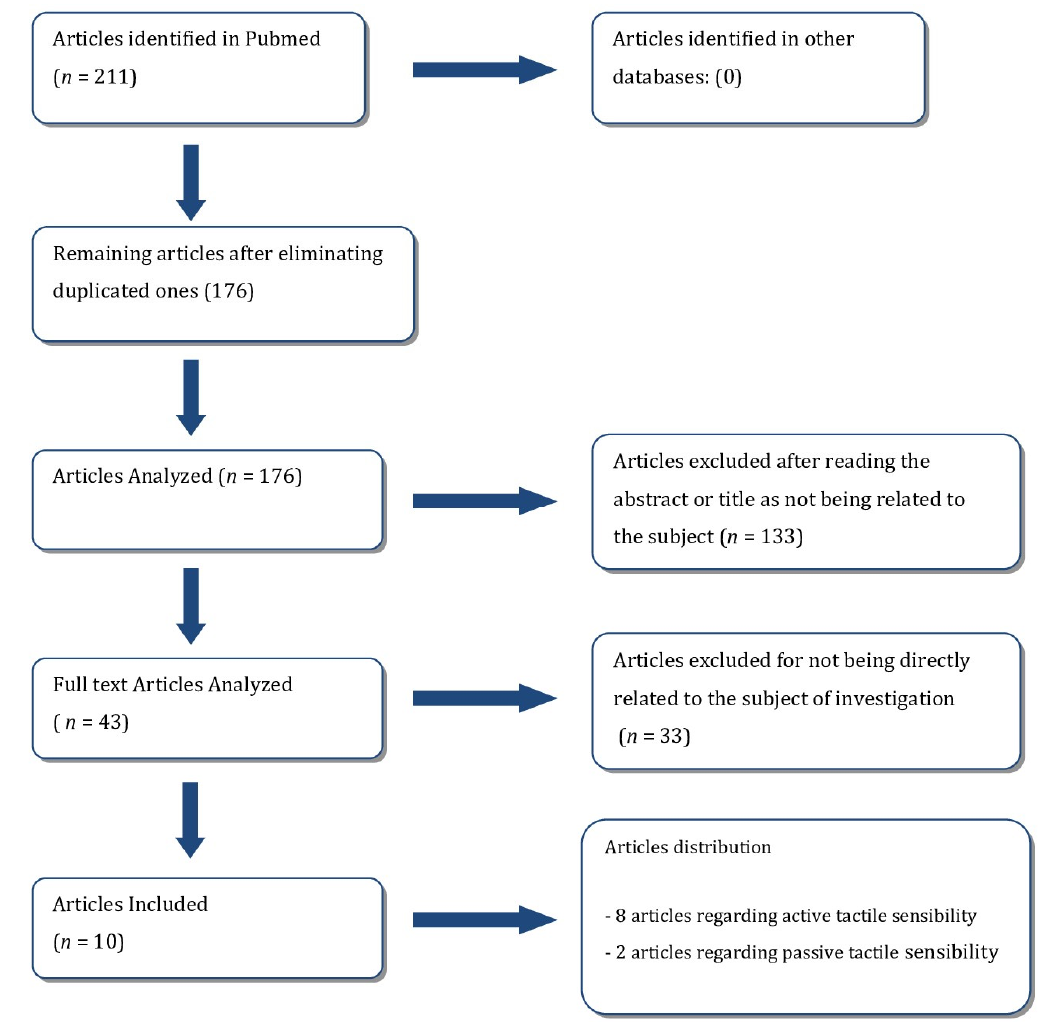
Figure 1. Pubmed Flowchart summarizing the review process.